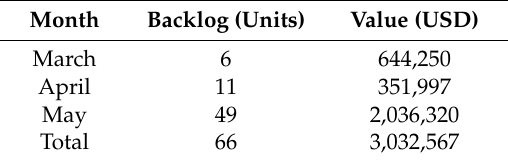
Table 9. The sales backlog (March 2016 to May 2016).